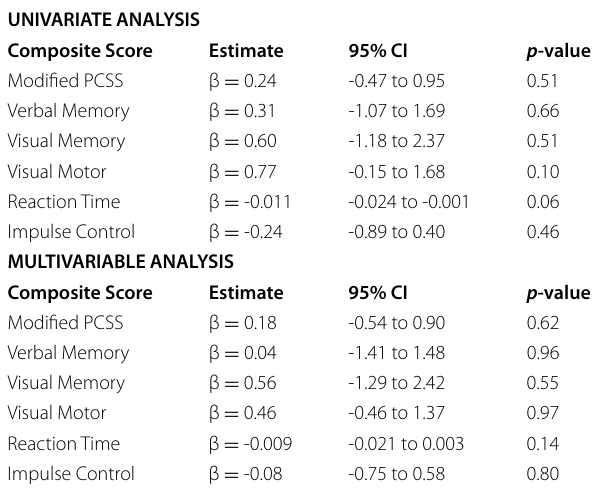
Table 5 Multivariable Linear Regression Analysis of the Effect of Migraine Treatment versus Treatment of Other Headache Types on Baseline Neurocognitive Function UNIVARIATE